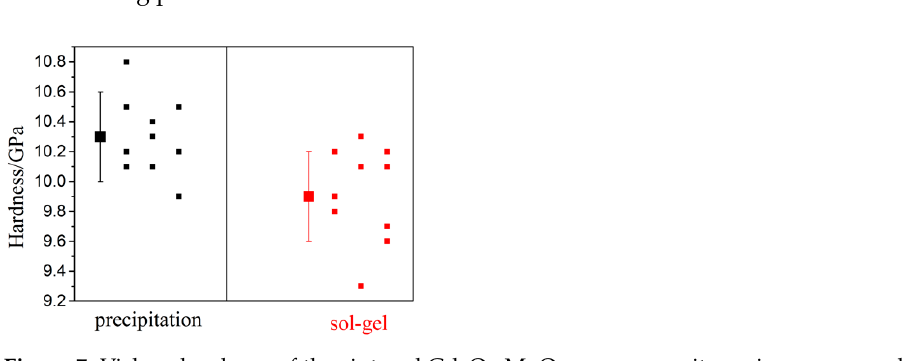
Figure 7. Vickers hardness of the sintered Gd 2 O 3 -MgO nanocomposites using nanopowders with different methods.